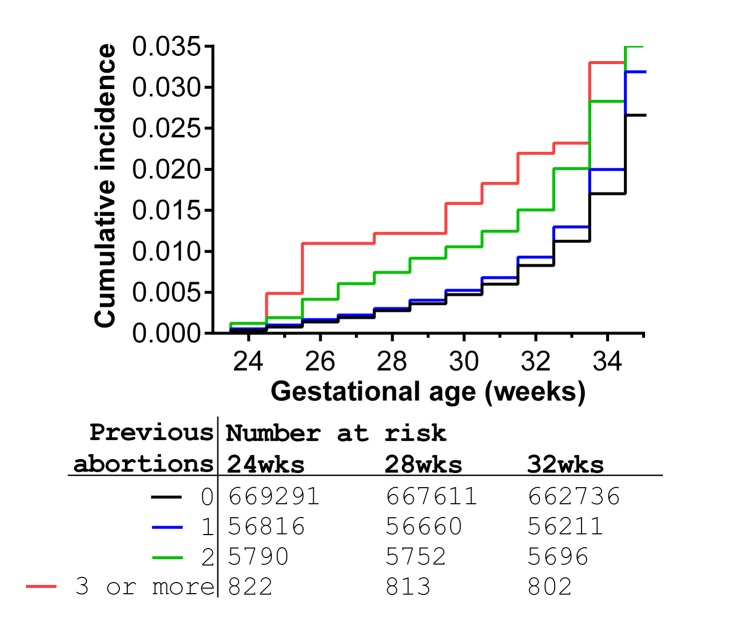
Cumulative incidence of preterm birth from 24 wk onwards in relation to number of previous abortions for 732,719 nulliparous women, Scotland 1980–2008.The relative risk of preterm birth for women with zero, one, two, or three or more previous abortions significantly varied across the range 24 to 36 wk gestational age (global test of proportional hazards assumption: p = 0.02). The graph is confined to the risk prior to 34 wk to allow better visualisation of the differences in incidence of extreme preterm births.